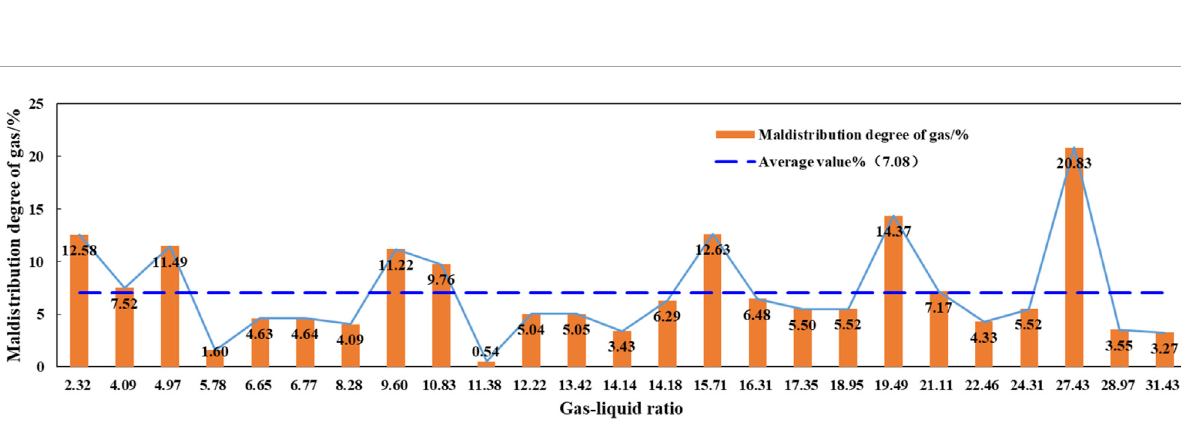
Frontiers in Earth